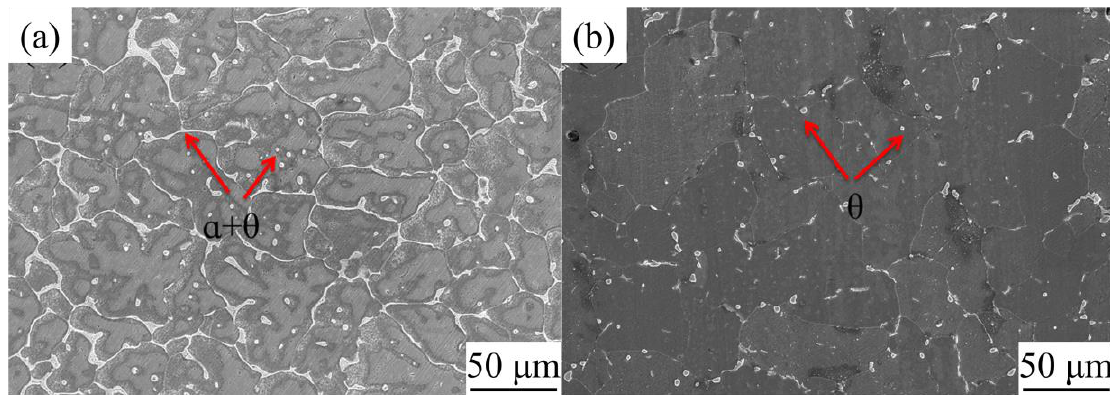
Figure 5. SEM images of ( a ) as-deposited and ( b ) T6 heat-treated.